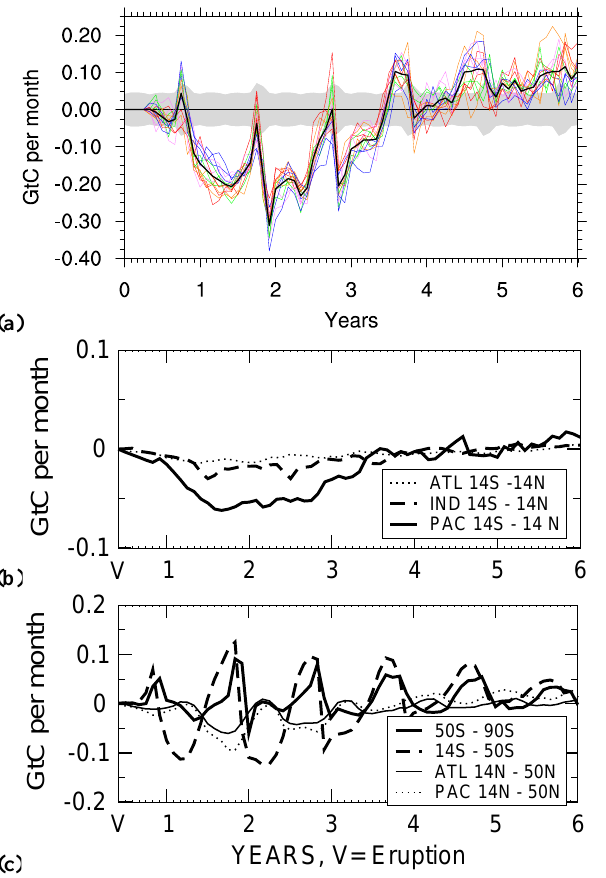
Fig. 13. As Fig. 12, but for the export flux of detritus at 90m depth (the bottom of the euphotic zone in the model). Note the different